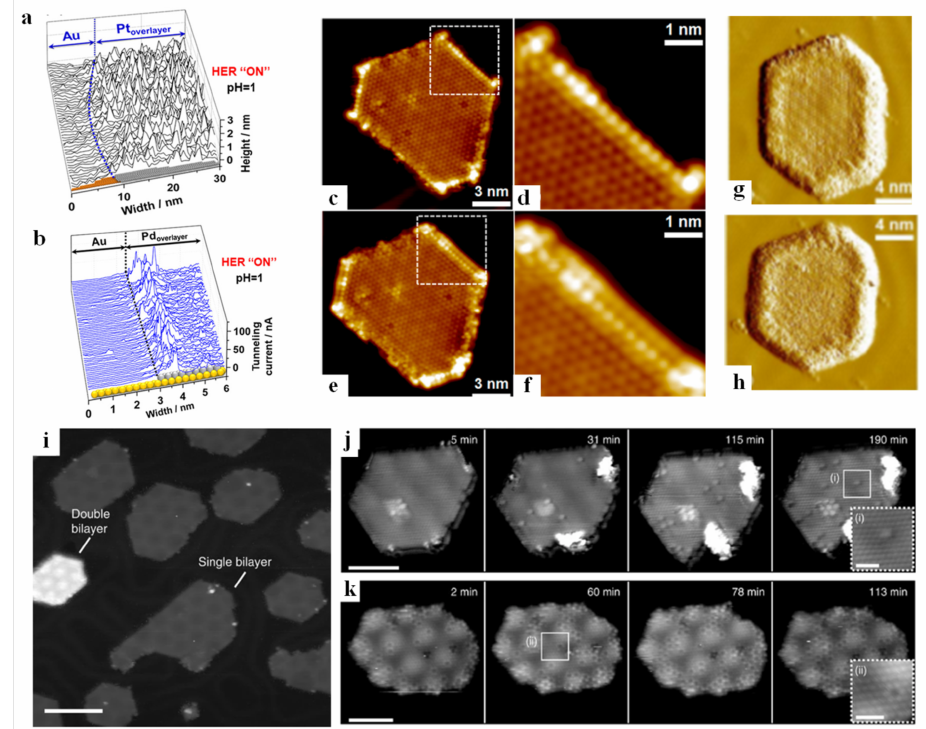
Figure 2. Corresponding line scans within the rectangular area indicated in example of an n-ECSTM picture (constant current mode) recorded under the HER ON conditions for a boundary between a Pt overlayer and Au (111) ( a ). Boundary between a Pd overlayer on Au and Au surfaces under HER conditions in 0.1 M H 2 SO 4 . Pd atoms located close to the boundary have the largest comparative contribution to the overall activity (STM constant height mode) ( b ). Adapted with permission from ref. [52]. Copyright 2019 American Chemical Society. Interaction between CeO x /Au (111) and CO 2 . STM images of the CeO x -Au (111) interface before ( c , d ) and after ( e , f ) CO 2 adsorption at 78 K. The square areas in ( c ) and ( e ) are magnified in ( d ) and ( f ), respectively. Sequential STM images of the CeO x island upon extended CO 2 exposure at 78 K ( g , h ). Adapted with permission from ref. [53]. Copyright 2017 American Chemical Society. Representative STM image showing a 30% ML synthesis of CoO nanoislands. Single and double bilayers are labelled ( i ). Image sequences from atom-resolved STM movie (supplementary) recorded during water exposure showing the initial stage of hydroxylation on single- ( j ) and double-bilayer ( k ) CoO nanoislands. Adapted with permission from ref. [54]. Copyright 2017 Springer